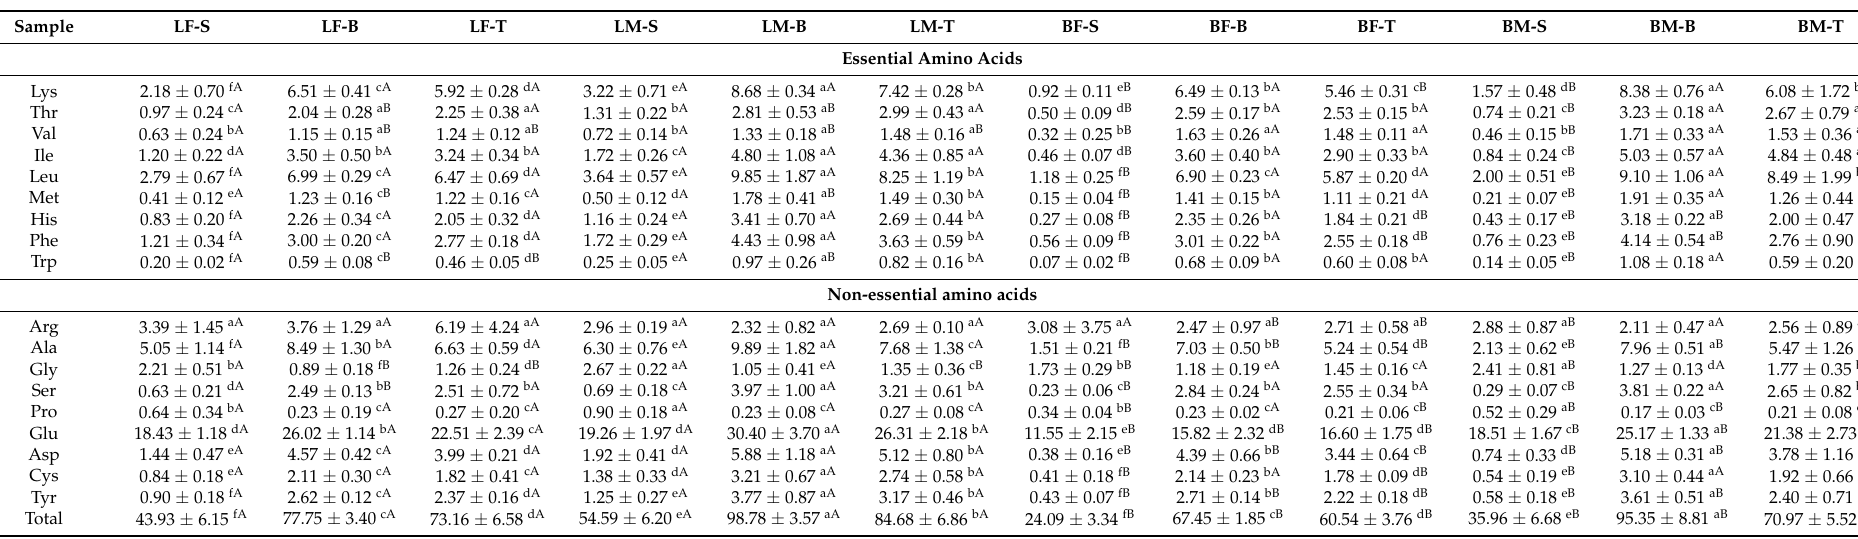
Table 4. Amino acid composition (g/100 g dry sample) of breast, thigh, and skin of broiler and Ligor hybrid chicken from different